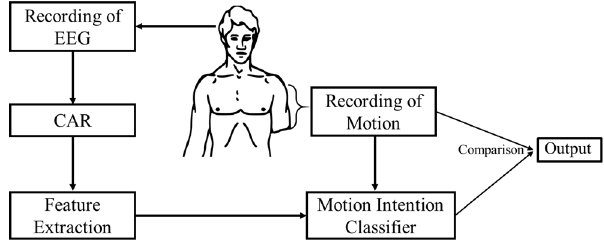
Figure 2. Proposed approach for motion identification. CAR: common average reference.